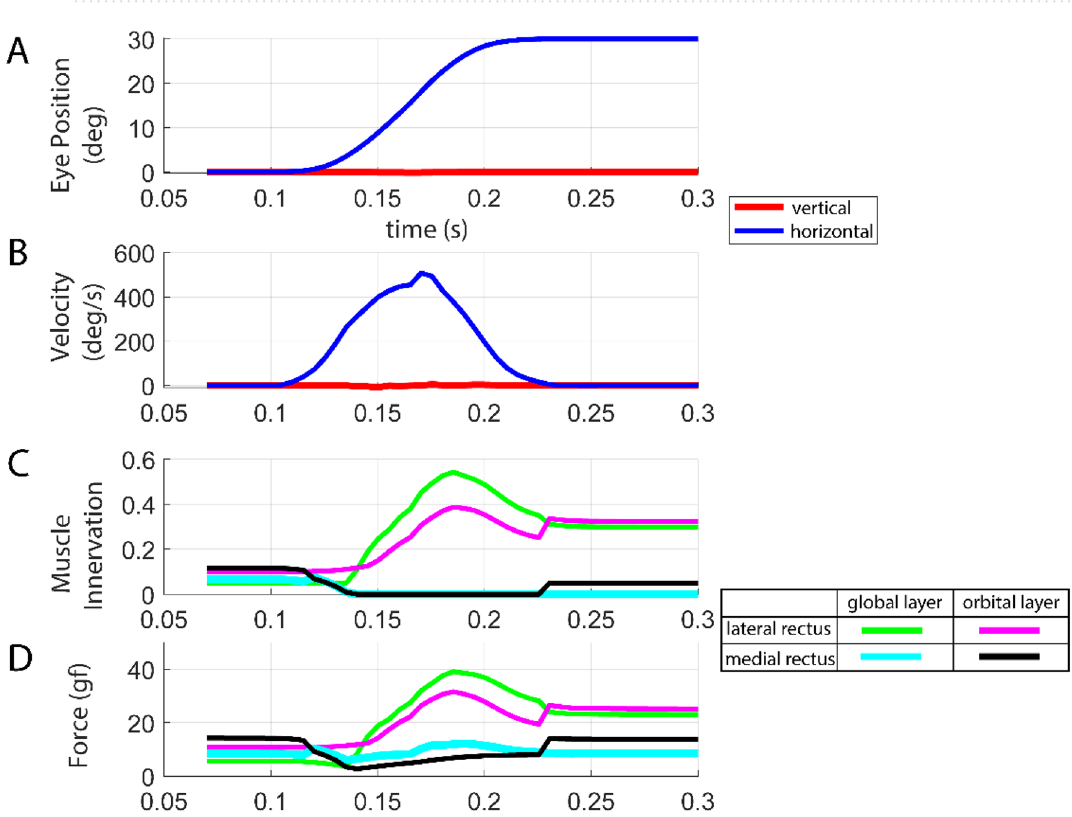
Figure 4. Simulation of a 30° saccade from central gaze to abduction: ( A ) eye position, ( B ) velocity, ( C ) innervation of lateral and medial rectus muscle, and ( D ) muscle